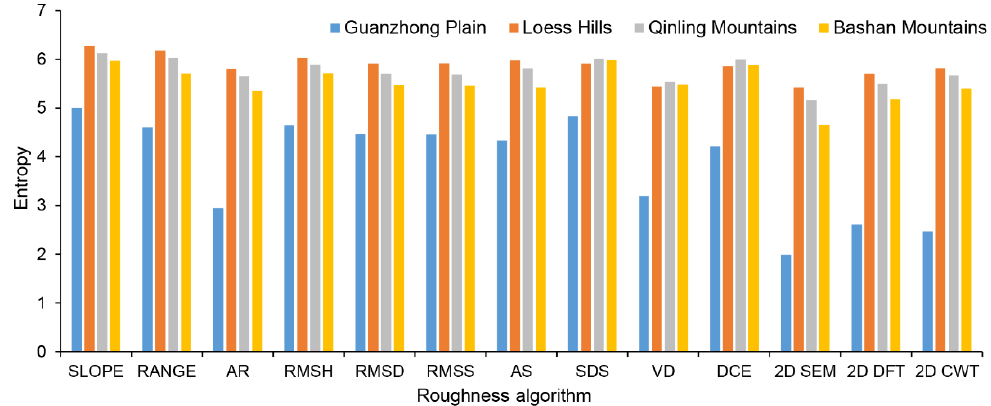
Figure 5. Information entropy of different roughness algorithms.